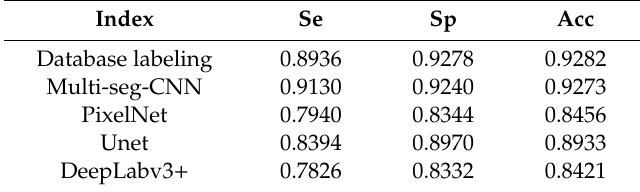
Table 3. Vessel segmentation accuracy by di ff erent networks.